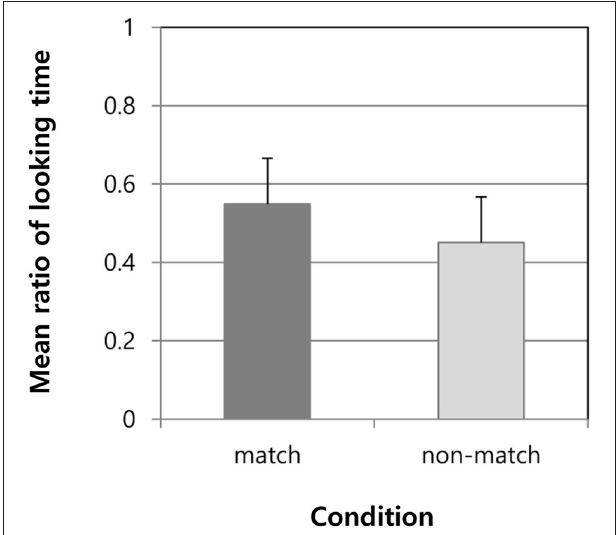
FIGURE 2 | Mean ratio of looking times during test trials in matched and non-matched conditions.